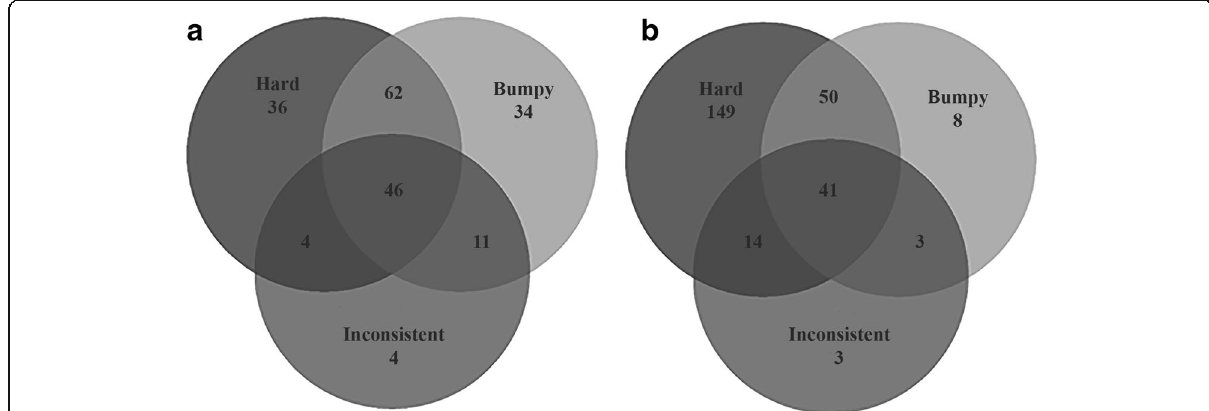
Fig. 8 The relationship between the three main surface properties from Q4.1.1.2 that were considered to be responsible for an injury sustained by a player on a natural turf (NT) and b artificial turf (AT)